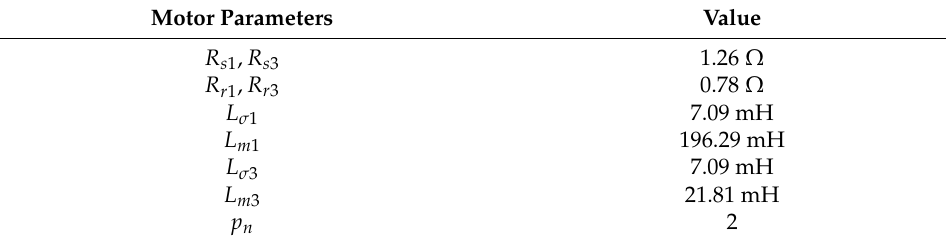
Figure 4. Control block diagram of the nine-phase induction motor based on MPC . Table 1. Parameters of the nine-phase induction motor. Motor